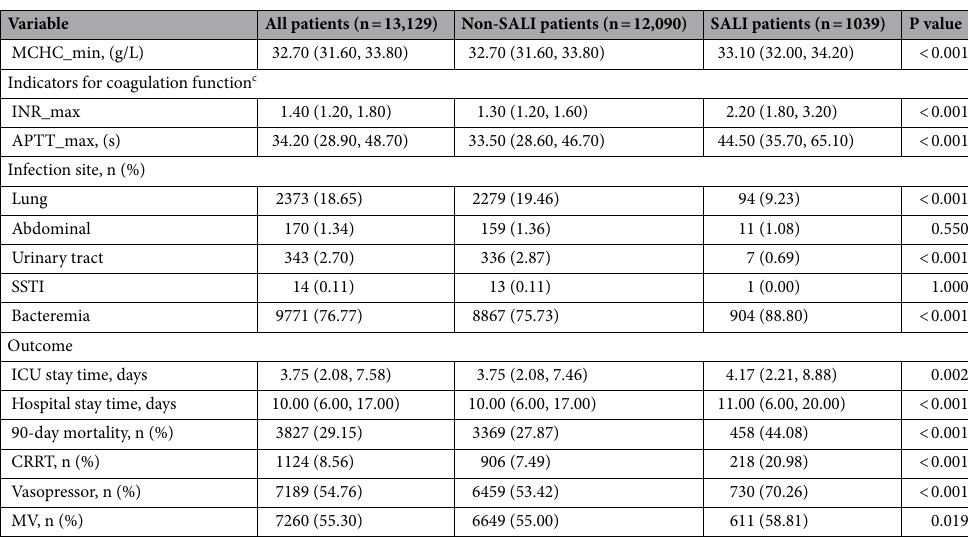
Table 1. The characteristics of patients included at first ICU admission. Categorical data are presented as frequencies (percentages), and parametric continuous data are presented as medians (interquartile ranges). SOFA score sequential organ failure assessment score, LODS score logistic organ dysfunction system score; SAPS II score simplified acute physiology II score, PH potential of hydrogen, PO2 arterial partial pressure of oxygen, PCO2 arterial blood carbon dioxide partial pressure, BUN blood urea nitrogen, Creatinine serum creatinine, TBIL total bilirubin, ALT alanine aminotransferase, AST aspartate aminotransferase, ALP alkaline phosphatase, WBC white blood cell, RDW red blood cell distribution width, MCV mean corpuscular volume, MCH mean corpuscular hemoglobin, MCHC mean corpuscular hemoglobin concentration, INR international normalized ratio, APTT partial thromboplastin time, SSTI skin and soft tissue infection. a First day of ICU usage means the number of ICU uses on the first day; CRRT continuous renal replacement therapy, MV mechanical ventilation. b Vital signs were calculated as the mean value during each patient’s first 24 h after